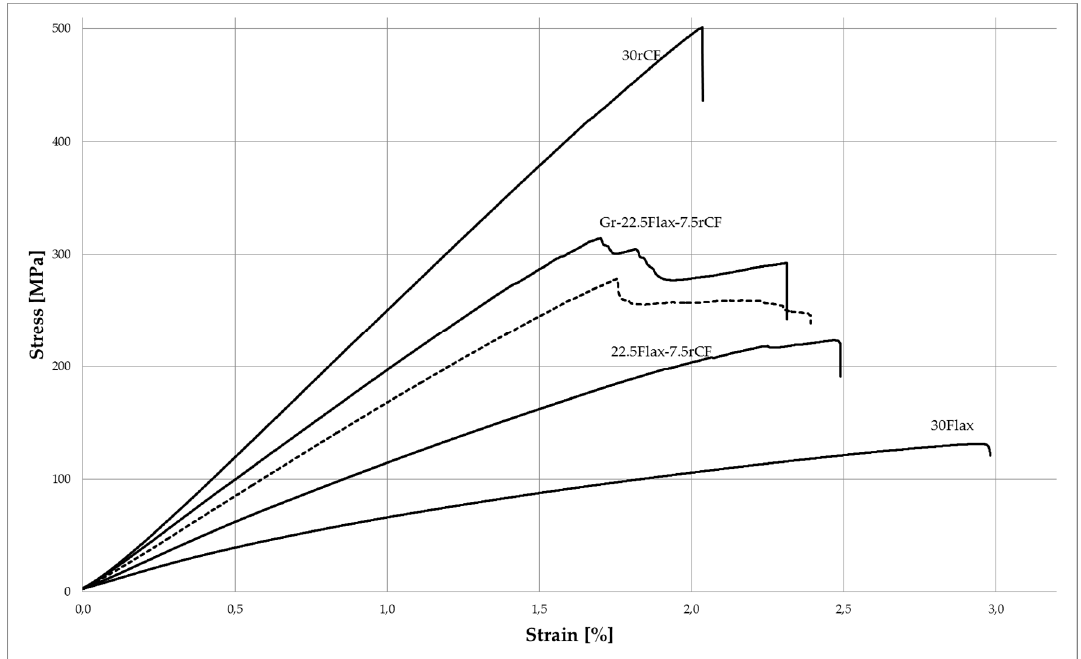
Figure 8. Stress-strain curves of three-point bending test samples in the 0° laminate test direction (similar to the machine direction of the nonwoven). For the sake of clarity, only one typical curve, with results comparable to the average values per set of specimens, is shown here. For Gr-22.5Flax-7.5rCF, a second dashed curve is indicating the considerable deviations between the test specimens because of the manual nonwoven production.